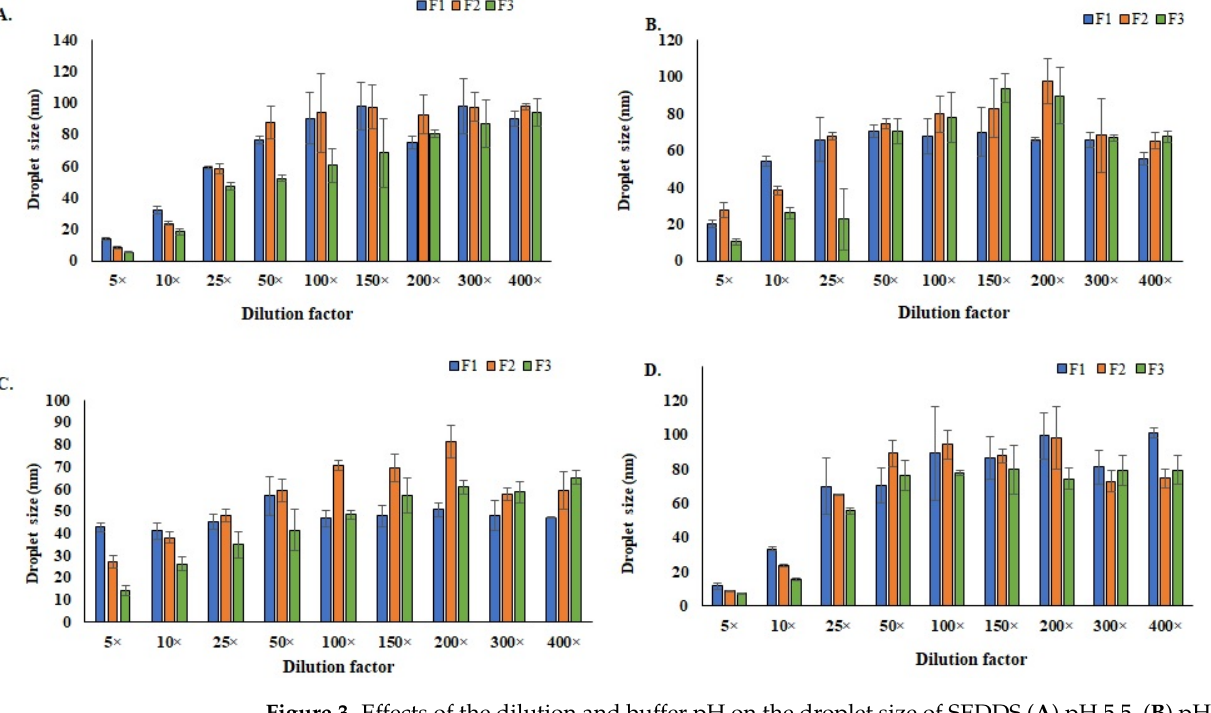
Figure 3. Effects of the dilution and buffer pH on the droplet size of SEDDS ( A ) pH 5.5, ( B ) pH 6.5, ( C ) pH 7.4, and ( D ) pH 8.5.